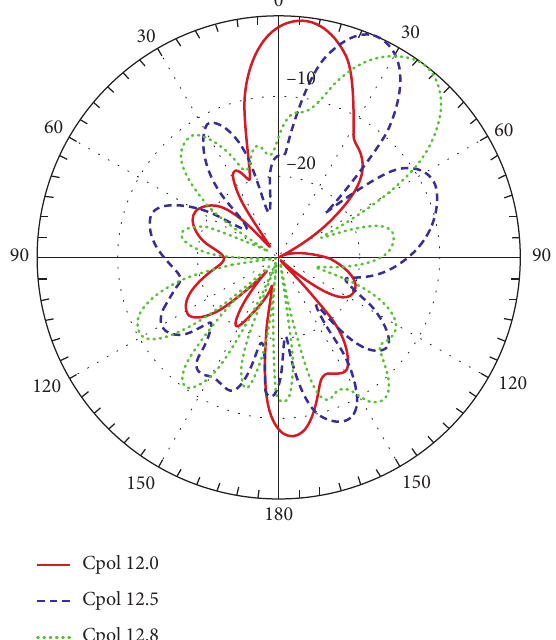
Figure 14: Simulated radiation pattern in E-plane (yOz plane); Cpol refers to the co-polarization (E θ )